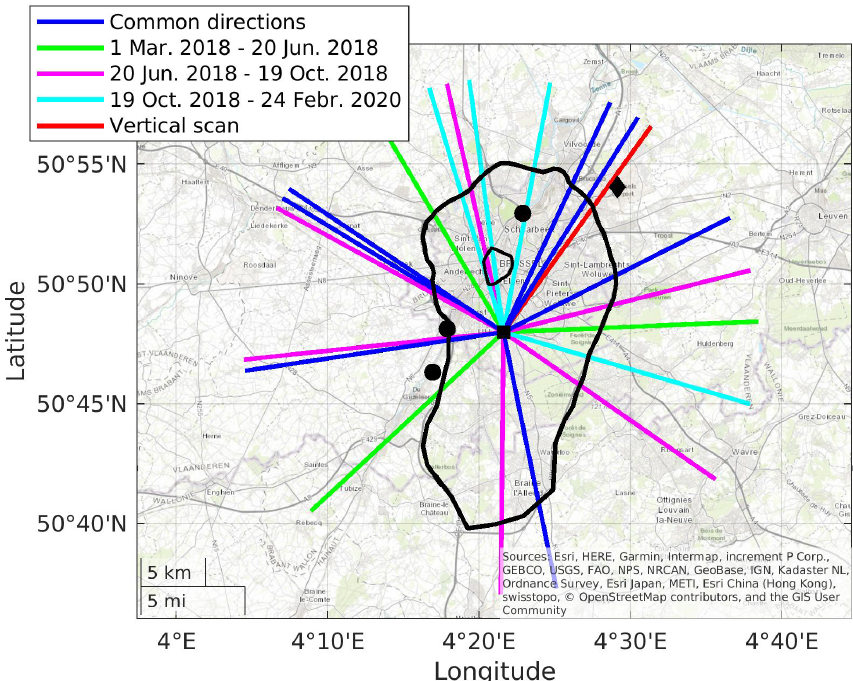
Figure 1. The experimental setup of the BIRA-IASB dual-scan MAX-DOAS instrument. Each line is color-coded according to the different setups that were used from March 2018 to February 2020. The length of each line is equal to 20km, which corresponds to the typical horizontal sensitivity for the MAX-DOAS measurements in the present study (see Fig. 18). The black square shows the MAX-DOAS instrument location, the black polygon the national airport, the black dots the NO 2 hotspots emitting more than 10kgNO x h − 1 (Emission Inventory of the Belgian Interregional Environment Agency, 2017; Frederik Tack, personal communication, 2019), and the black line the Brussels Ring